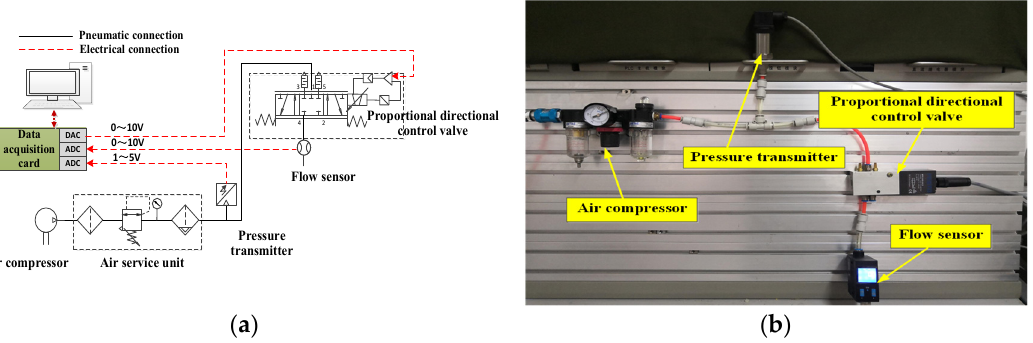
Figure 6. Pneumatic circuit diagram: ( a ) schematic; ( b ) experimental test platform.